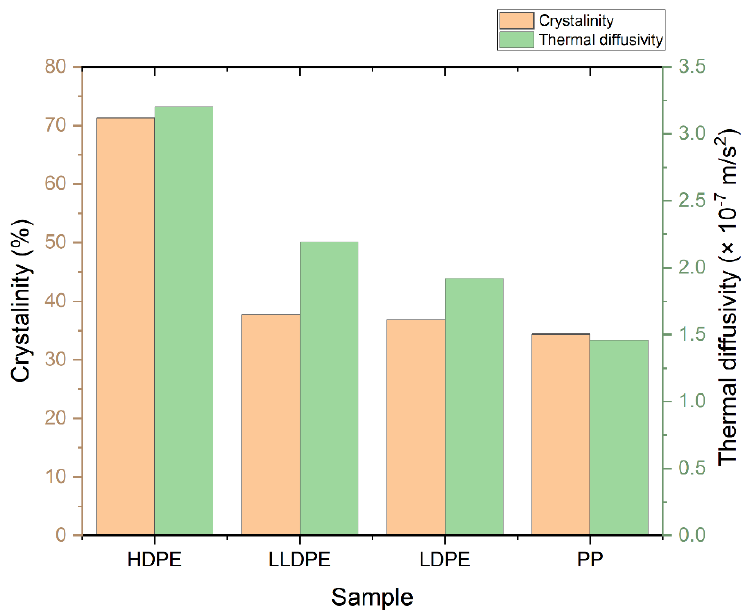
Figure 11. The percentage crystallinity and D of polyolefins.